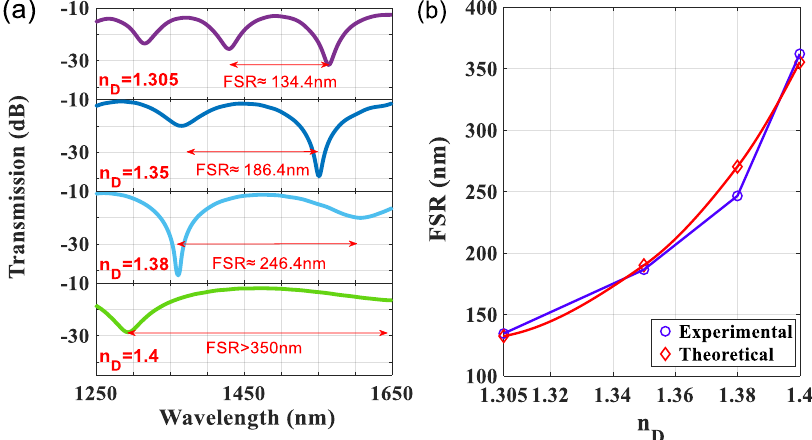
Figure 7. ( a ) Measured transmission spectra for LLCFMZI filled with Cargille-liquid with different n D = 1.305, 1.35, 1.38, 1.40. ( b ) Comparison of FSR for theoretical and experimental values. By using the technique of cleaving HCF, the LLCFMZIs with different L of HCF were fabricated. They were filled with the same liquid of Cargille-liquid (n D = 1.305) and their spectral interference fringes, as well as optical characteristics, were measured, as shown in Figure 8. The FSRs are 134.4, 95.2, and 71.2 nm, corresponding to the HCF of ~100, 150, and 200 µ m, respectively. It can be observed from Figure 8a that optical light leaks with a larger energy loss in the transmission spectra as the L becomes longer. The insertion losses are − 13.11, − 13.56, and − 16.1 for the cases of L = 100, 150, and 200 µ m, respectively.